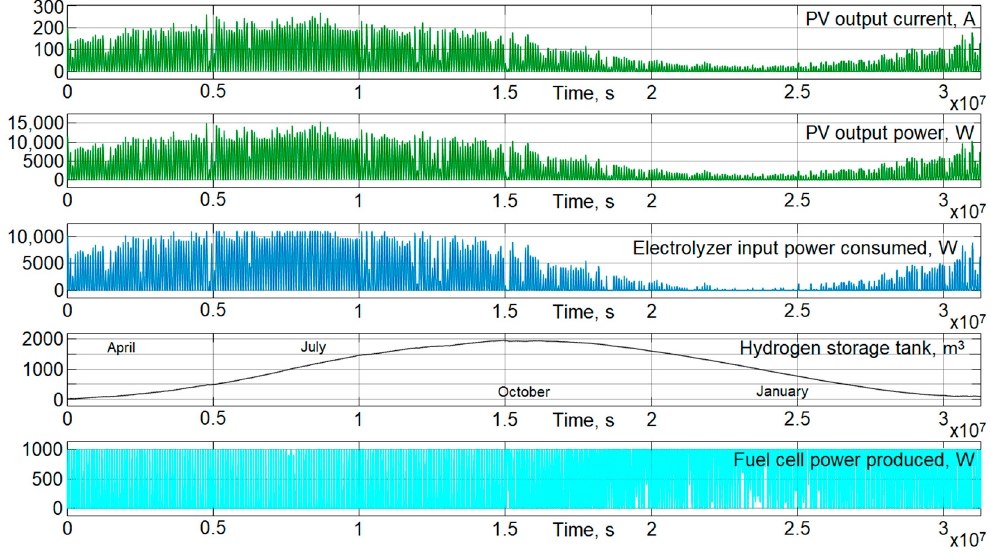
Figure 17. The result of the simulation and calculation of the required hydrogen tank capacity for the location Chelyabinsk, Russia.